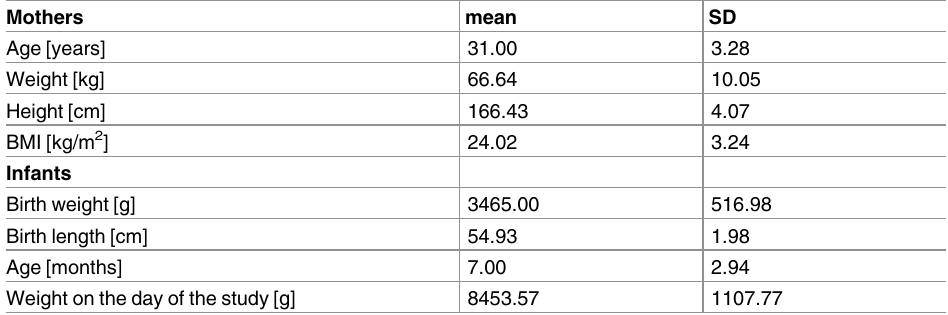
Table 1. Demographic characteristics of the mothers and their infants included in the study [n =